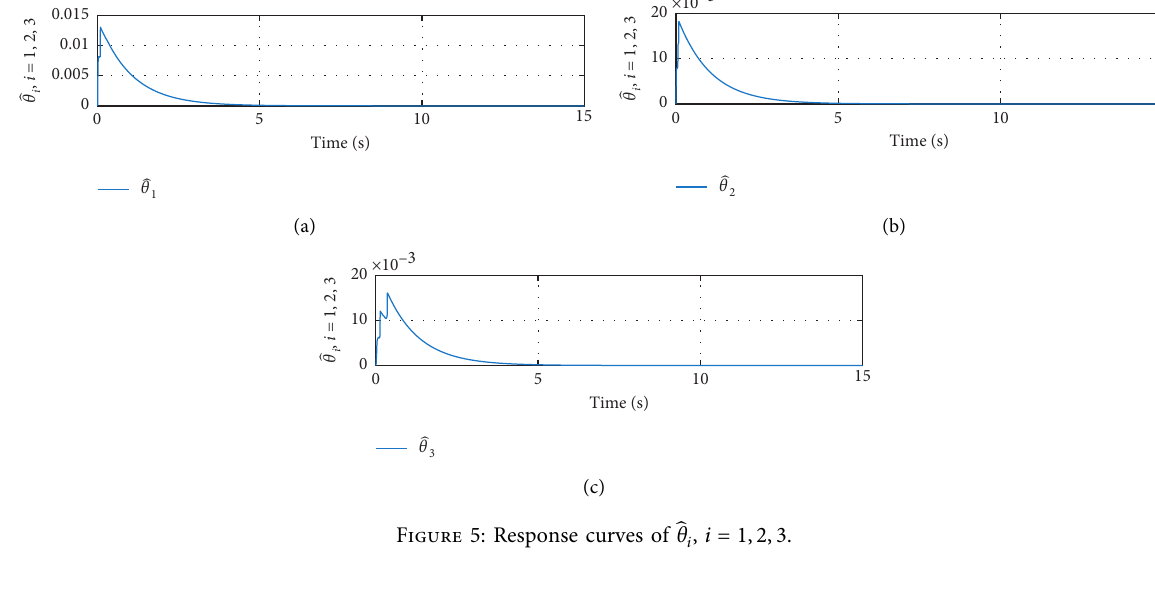
, i � 4 , 5 , 6. i and α i, 1